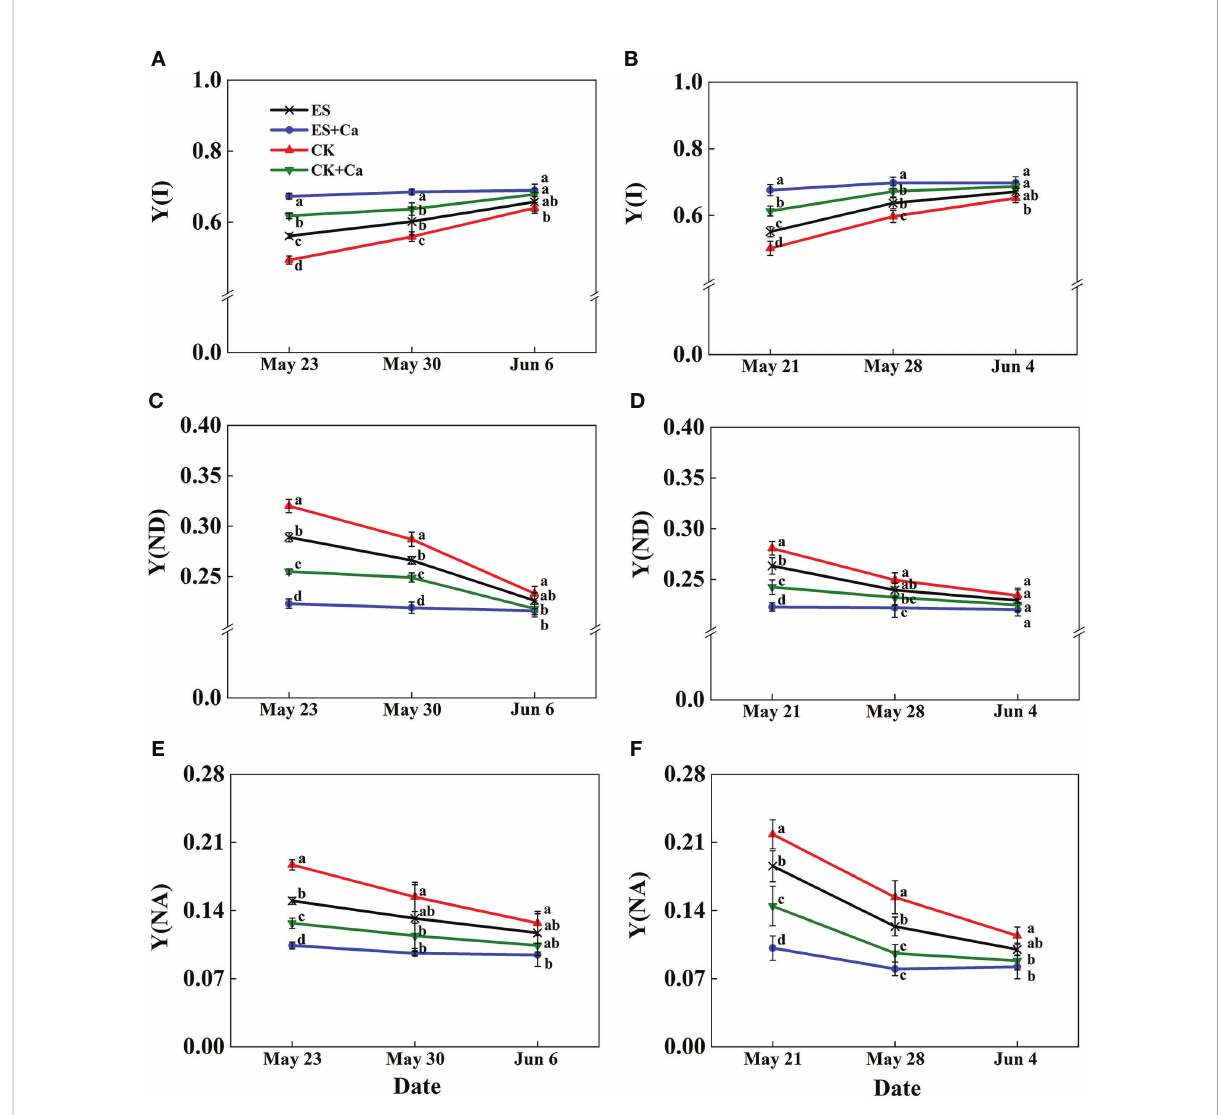
FIGURE 9 Effects of exogenous foliar calcium (Ca 2+ ) application on peanut PSI photochemistry effective quantum yield [Y(I), A , B ], PSI non-photochemical energy dissipation due to the donor-side limitation [Y(ND), C , D ], PSI non-photochemical energy dissipation due to the acceptor-side limitation [Y(NA), E , F ] under early and normal sowing scenarios. Values are means ± SD (n = 3). Different letters indicate signi fi cant differences according to Duncan ’ s multiple range tests ( p <